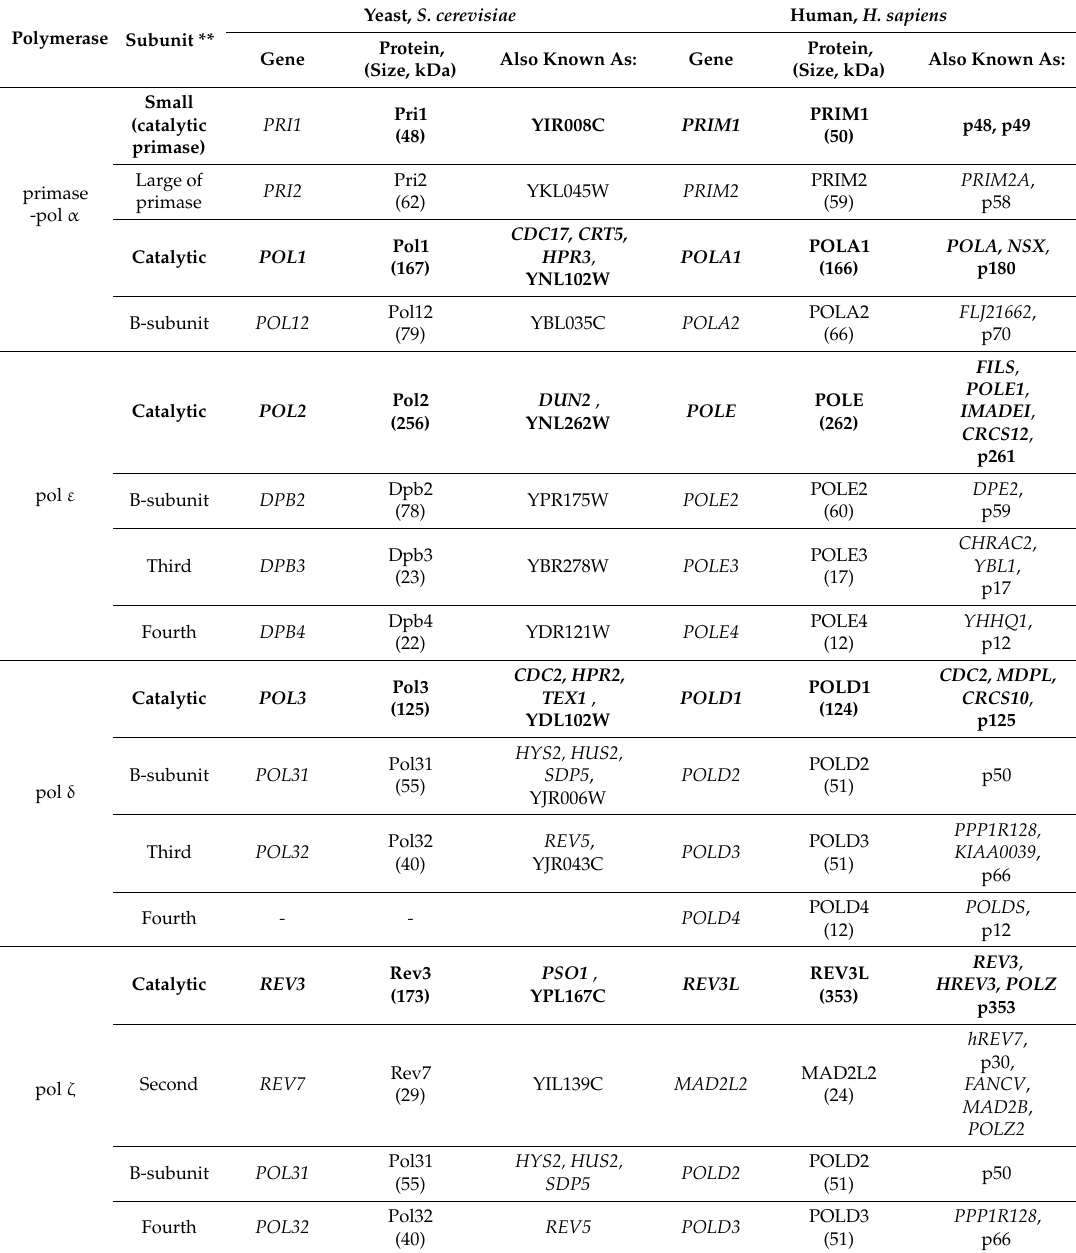
Table 1. Nomenclature of subunits of yeast and human B-family DNA polymerases